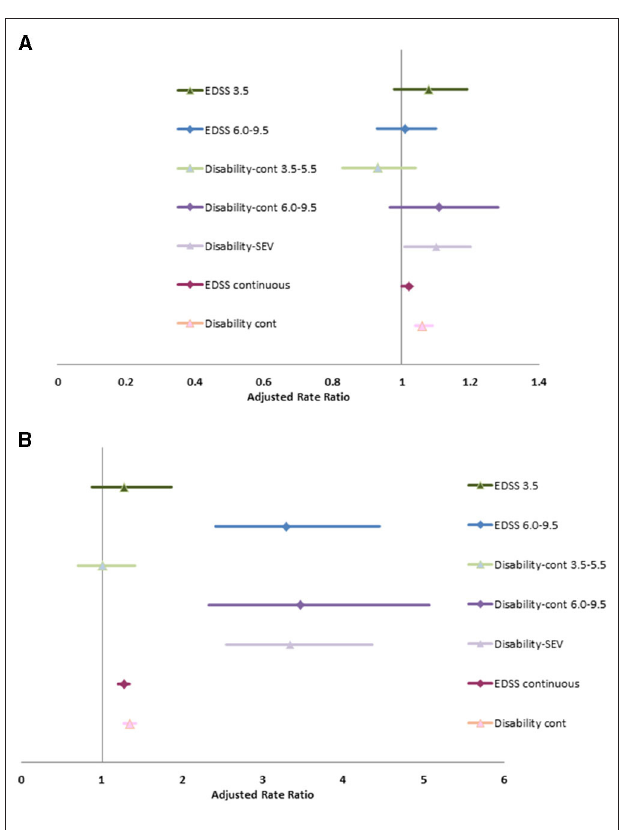
FIGURE 1 | Association of disability status with physician visits (A) and hospitalizations (B)